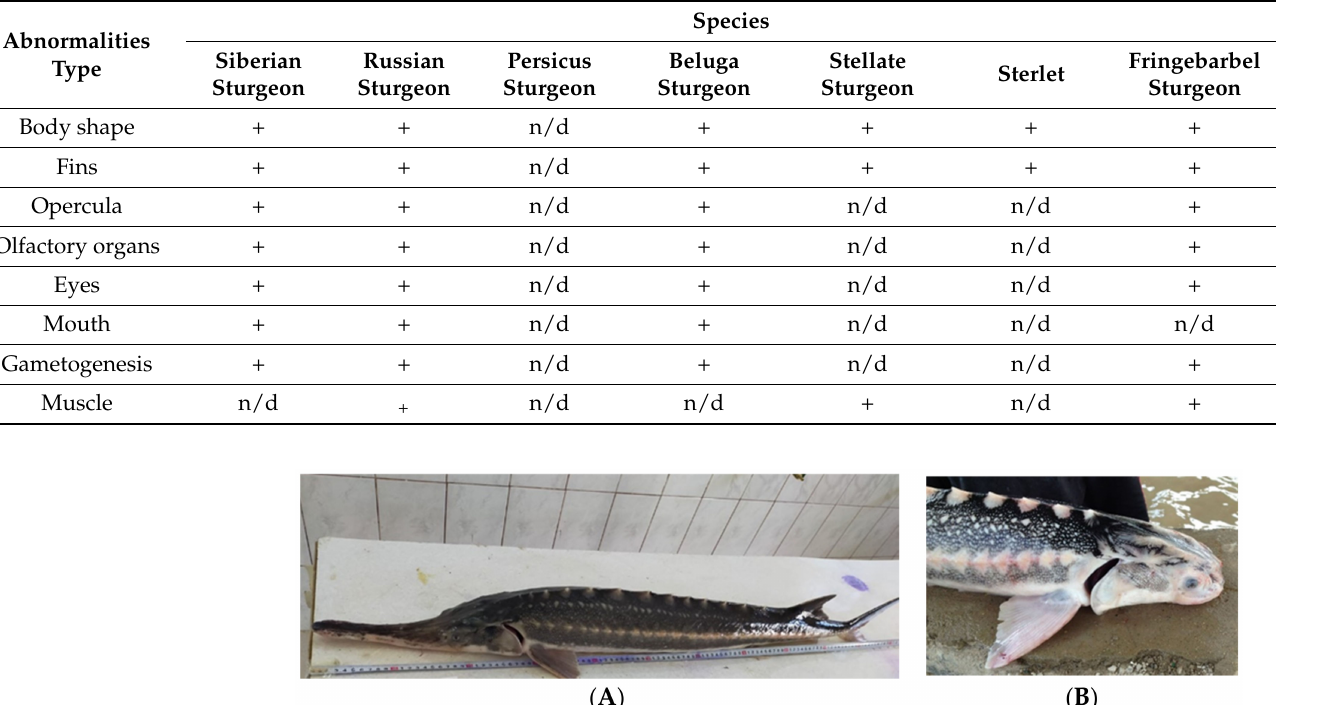
Table 2. Types of morphological abnormalities in the structure of body and external organs in sturgeons, (+)—presence, n/d—no data.